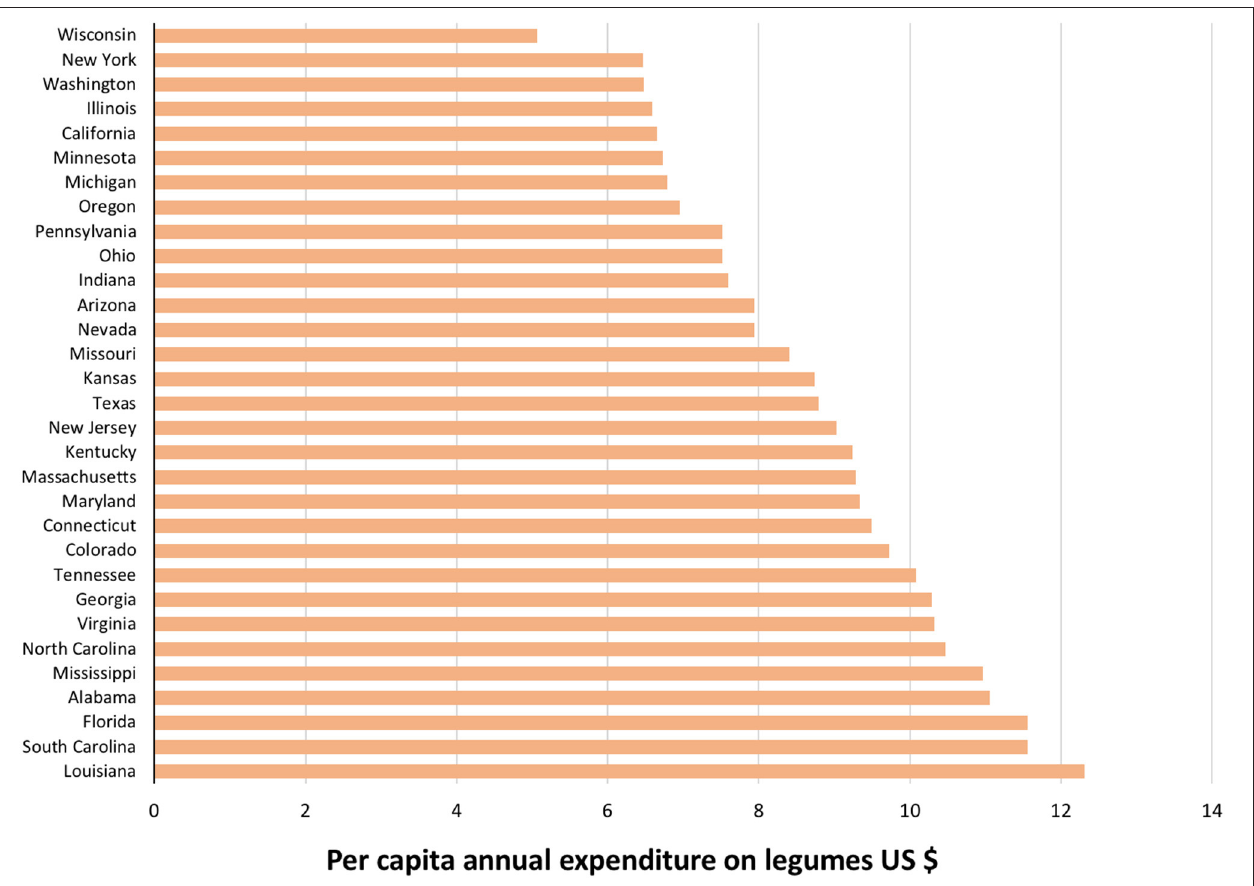
FIGURE 2 | Per capita expenditure on legumes by state based upon Nielsen retail grocery scanning data, average over 2017–2019 period.